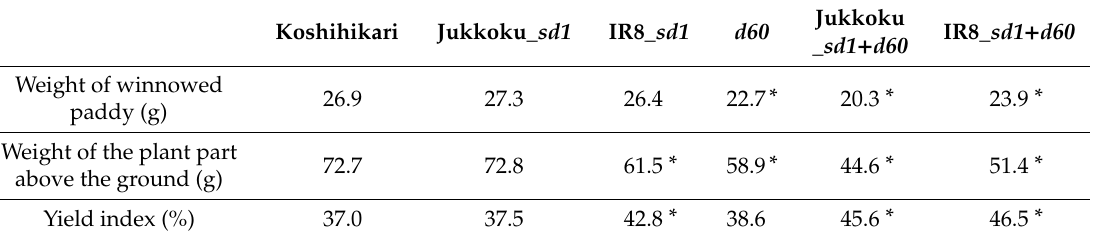
Figure 8. Yield index of semidwarf and double dwarf gene lines. The yield index was higher in line carrying IR8_ sd1 than in those carrying Jukkoku_ sd1. The yield index for Jukkoku DW and IR8 DW are 45.6% and 46.5%, respectively higher than that of Koshihikari. Table 7. Effect of semidwarf and double dwarf genes to yield index.